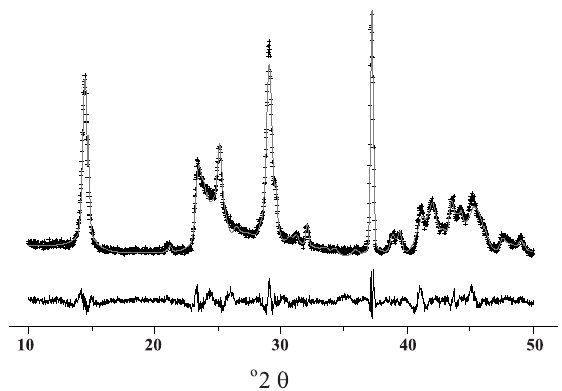
Figura 2. Espectro de DRX (cruzes), curva ajustada pelo refinamento Rietveld (linha preta contínua sobre as cruzes) e diferença entre o perfil calculado e o observado (linha preta contínua situada abaixo do gráfico) da fração argila do perfil PV , horizonte BA. 1